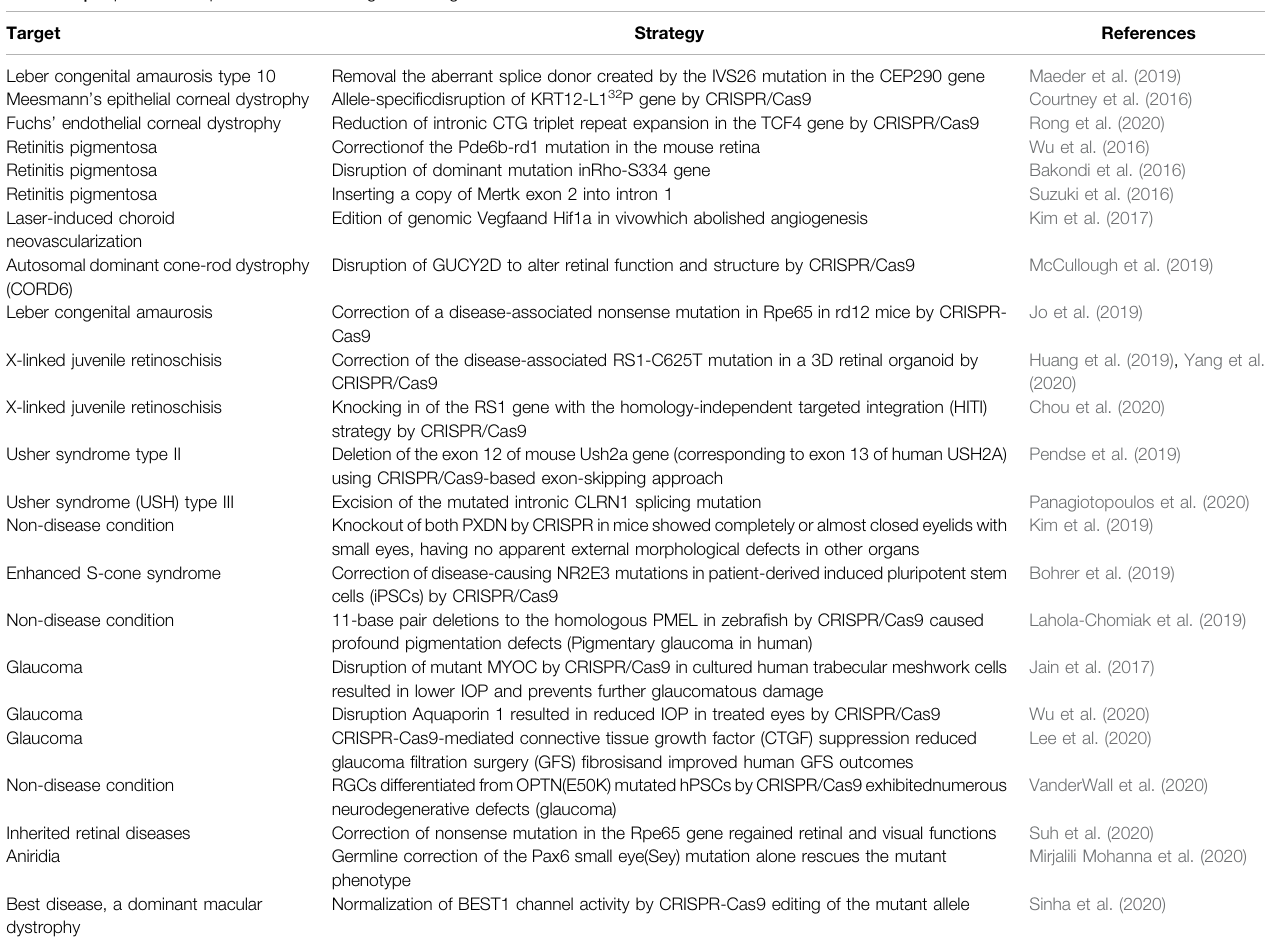
TABLE 2 | Representative preclinical studies of gene editing for ocular